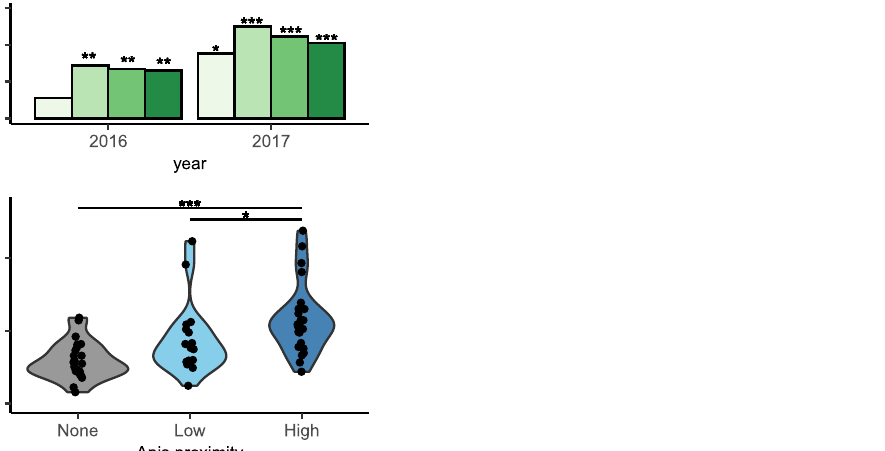
Associated with wasp colony density Spatially autocorrelated